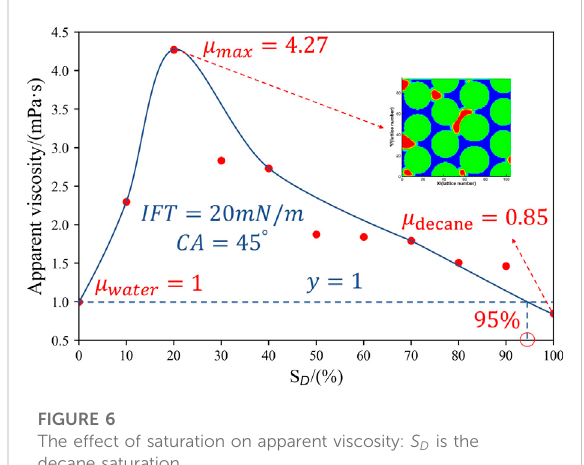
FIGURE 6 The effect of saturation on apparent viscosity: S D is the decane saturation.